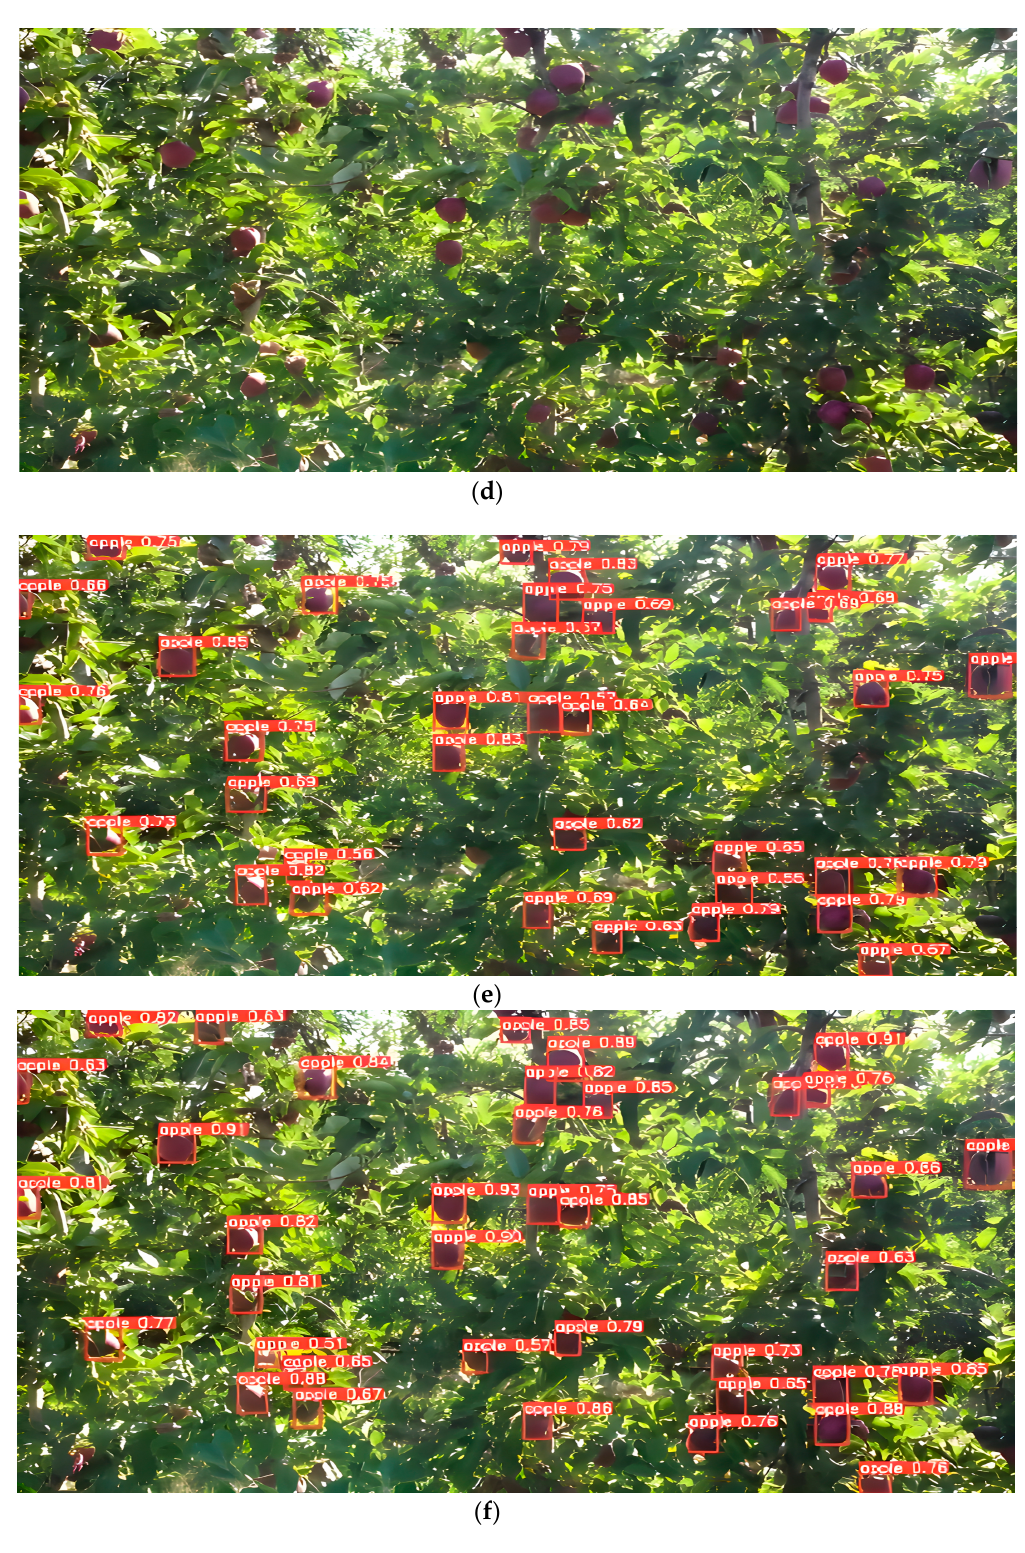
Figure 9. Apple (red delicious) detection outcome for normal images; ( a ). Apple (red delicious) original image 1 (frame 750); ( b ) apple (red delicious) detection by original Yolov5; ( c ) apple (red delicious) detection by proposed Yolov5; ( d ) apple (red delicious) original image 2 (frame 750); ( e ) apple (red delicious) detection by original Yolov5; ( f ) apple (red delicious) detection by proposed Yolov5. The Figure 10a,d shows the sample input images and Figure 10b,e depicts the detec- tion by Yolov5 and Figure 10c,f shows gold delicious apple detection by proposed Yolov5.